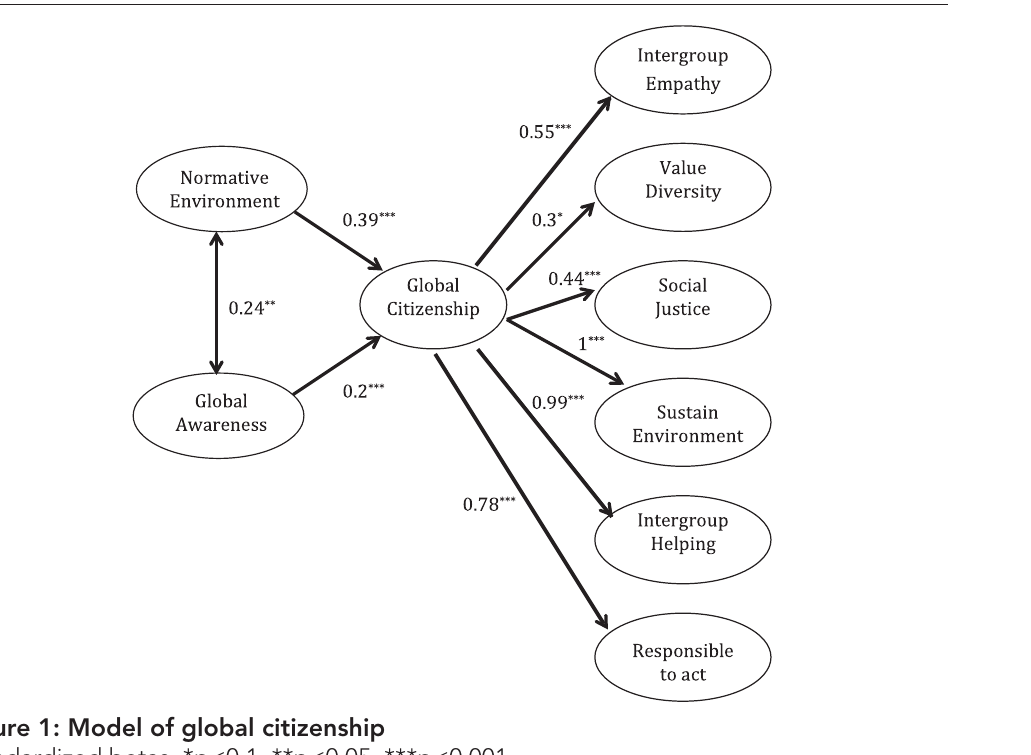
figure 1: model of global citizenship Standardized betas, *p<0.1, **p<0.05,